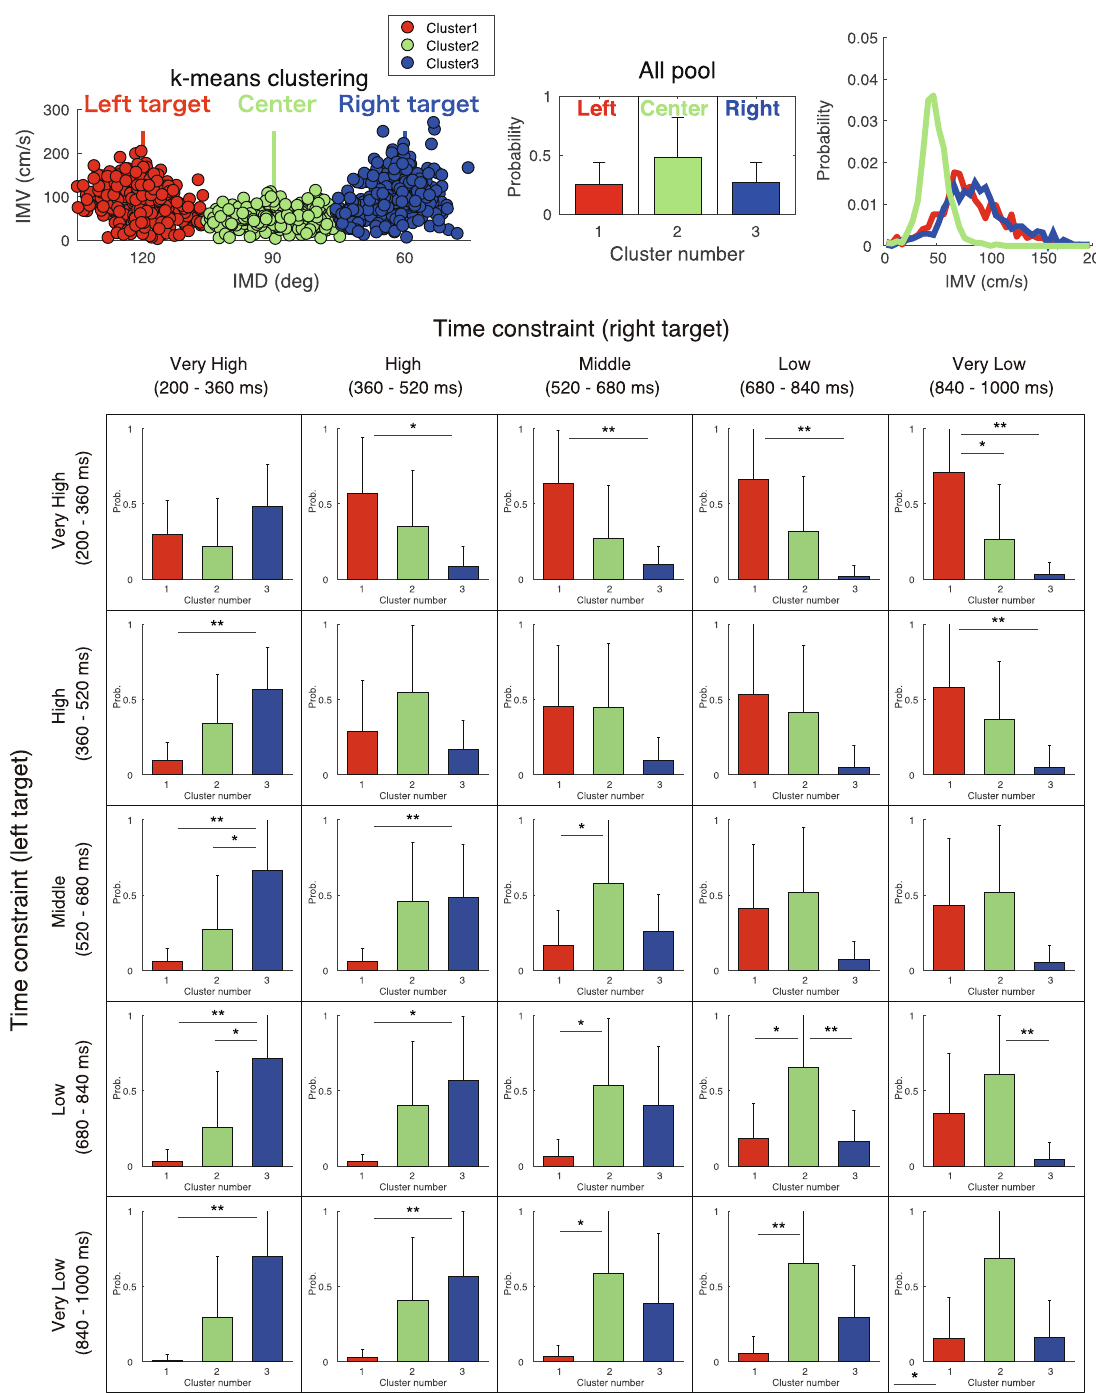
Figure 4. Clustering of the initial movement and the probability of appearance of movement patterns according to time constraints. The upper left panel shows a scatter plot of the movement direction and velocity of the initial movement, including data from all participants. The data were classified into three clusters (red, green, and blue) by k-means clustering for the bivariate initial movement variables (i.e., the IMD and IMV). The upper center panel shows the between-participant mean of the probability of occurrence of each cluster under all time constraints. Error bars are between-participant standard deviations. The upper right panel shows the histograms of IMV in each cluster. It was confirmed that the IMV in the center direction (green) was slower than that in the target directions (red and blue). The bottom panels show the between-participant average of the probability of occurrence of each cluster, depending on the time constraint. This figure shows that when the time constraints are equal, the occurrence probability of the intermediate direction (green) is higher, and with differences in the time constraints, the occurrence probability of the initial movement to the target direction (red and green) with a shorter time constraint is